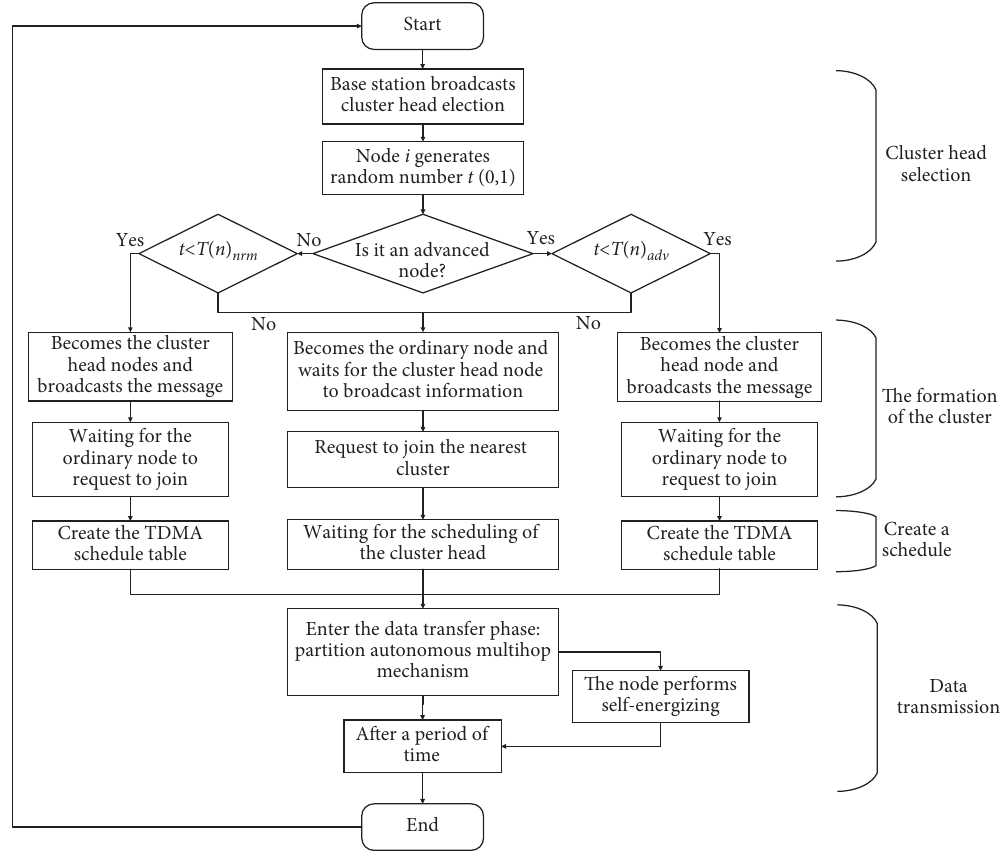
Figure 3: Flow chart of operation in each round of FOI-LEACH